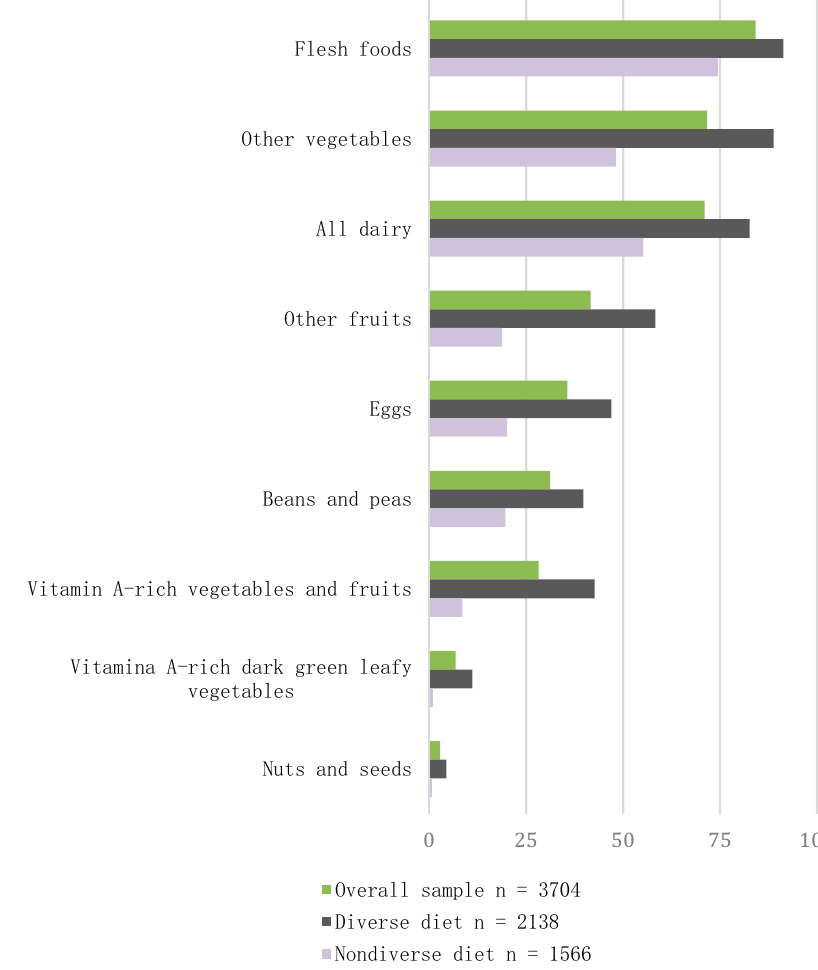
Figure 1. Proportion (%) of participants consuming each food group over one 24 h recall period in ELANS. Overall ( n = 3704), diverse ( n = 2138) consuming ≥ 5 food groups, and non-diverse ( n = 1566) consuming <5 food groups.